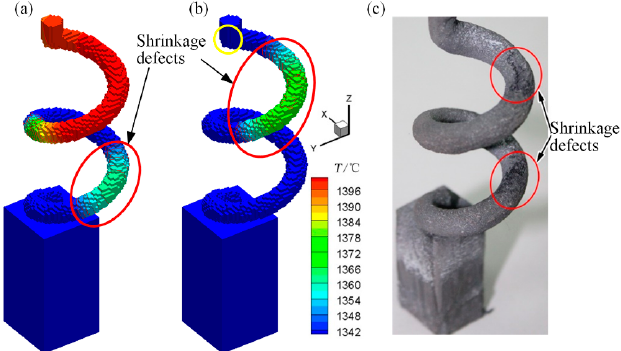
Figure 17. Simulation analysis and experiment of shrinkage defects in selector with h s = 14 mm and d s = 14 mm: ( a ) temperature field ( t = 20 min); ( b ) temperature field ( t = 23 min) and ( c ) experimental result.